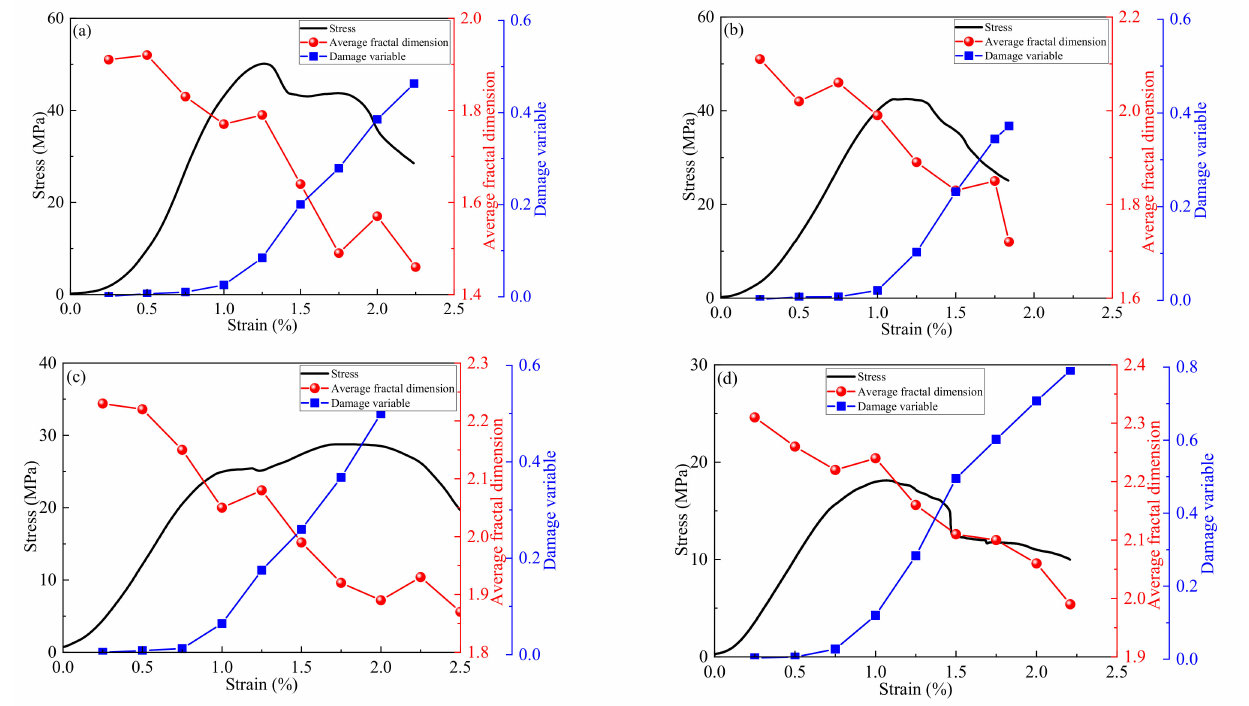
Figure 12. AE average fractal dimension: ( a ) RBCM-10; ( b ) RBCM-20; ( c ) RBCM-30; ( d )